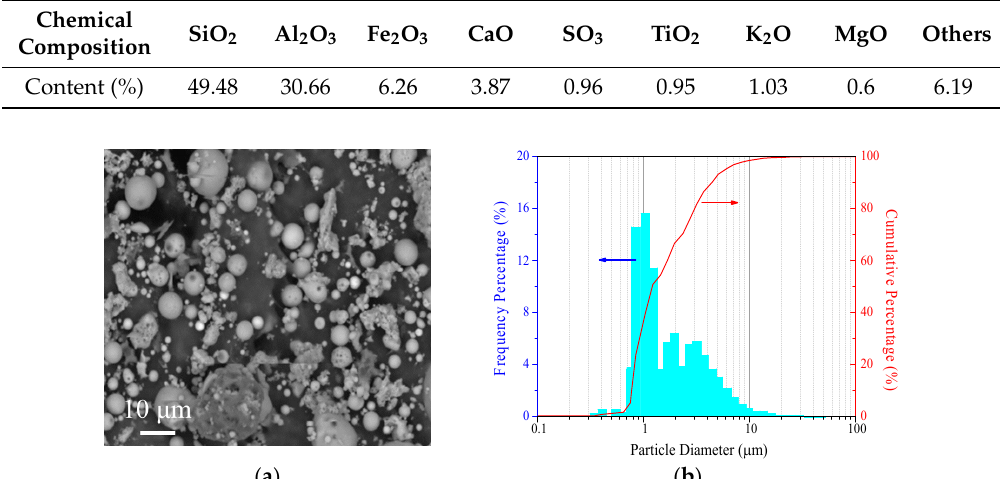
Table 1. Chemical composition analysis of ultrafine CFA.